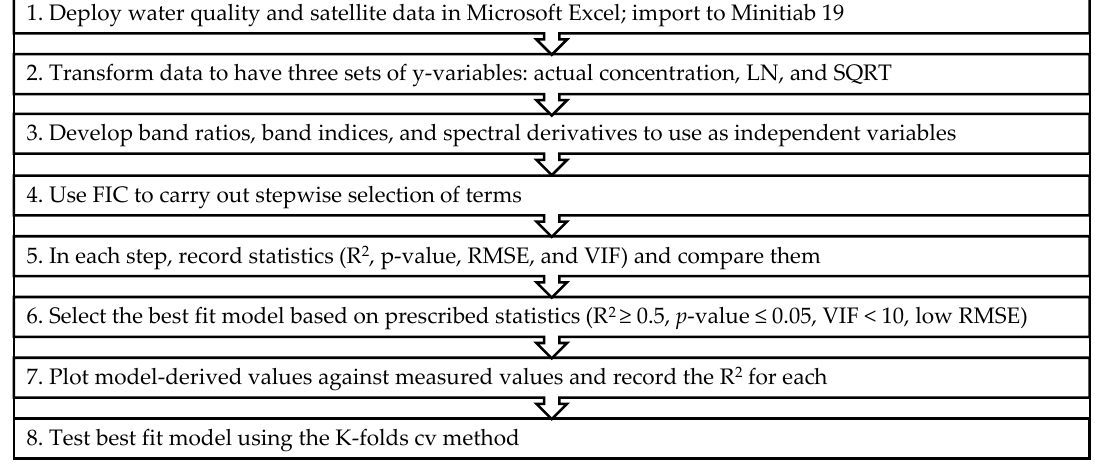
Figure 2. Flow diagram showing the procedure for model development, model selection, and model validation .